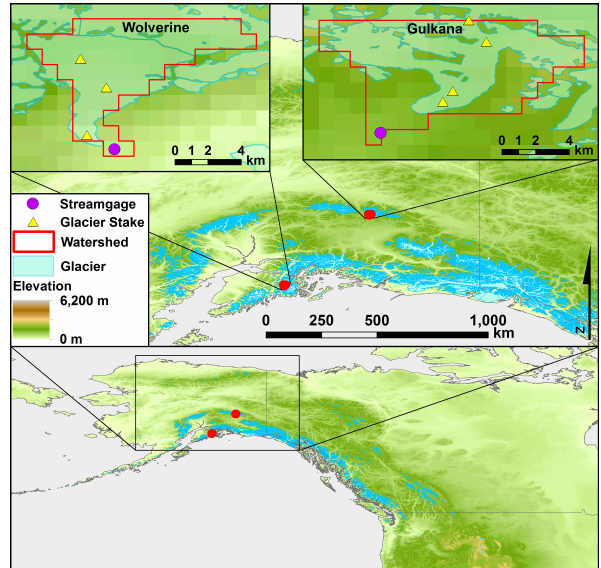
Figure 1. Gulkana and Wolverine model domains are depicted us- ing insets in the upper right and upper left, respectively. While the model is implemented for the entire rectilinear region, the red bor- der highlights the grid cells contributing to streamflow at the US Ge- ological Survey (USGS) stream gages in each domain. The digital elevation model is produced by WorldClim (Hijmans, 2011) and glacier coverage is from the Randolph Glacier Inventory version 5 (Pfeffer et al.,